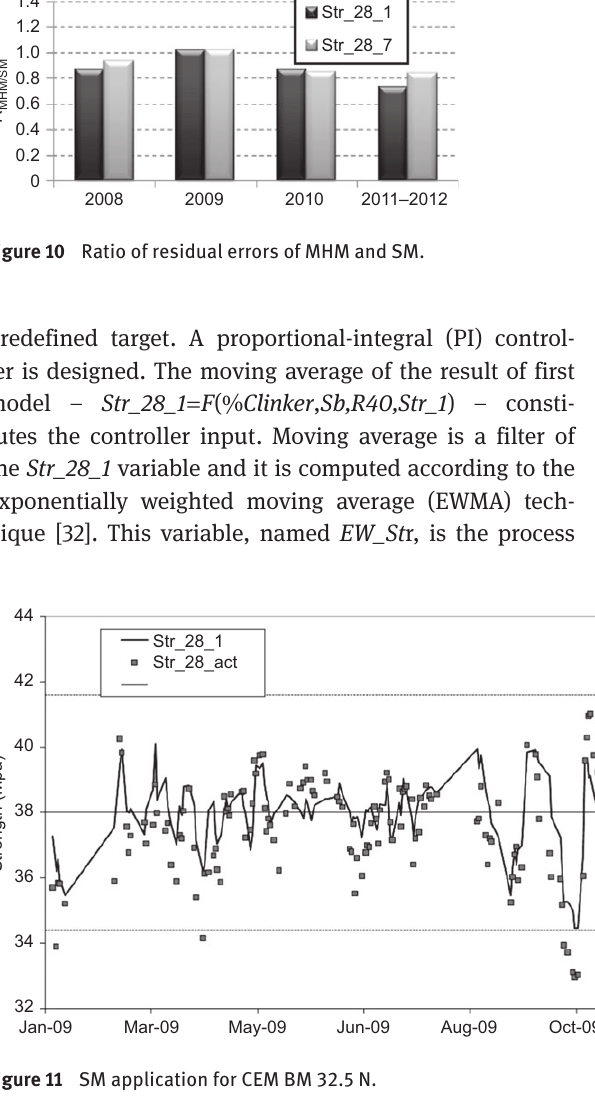
variable of the feedback loop. Clinker content, % Clink , is